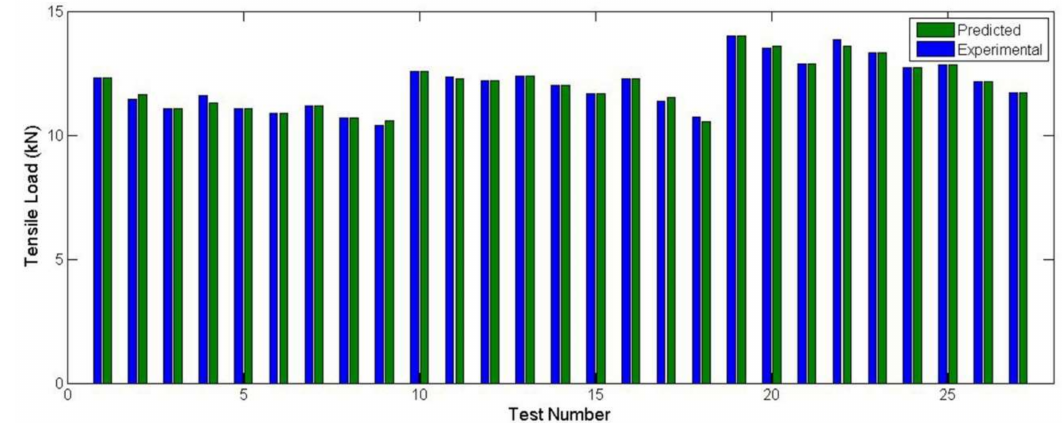
Figure 12. Comparison of experimental and predicted tensile loads of